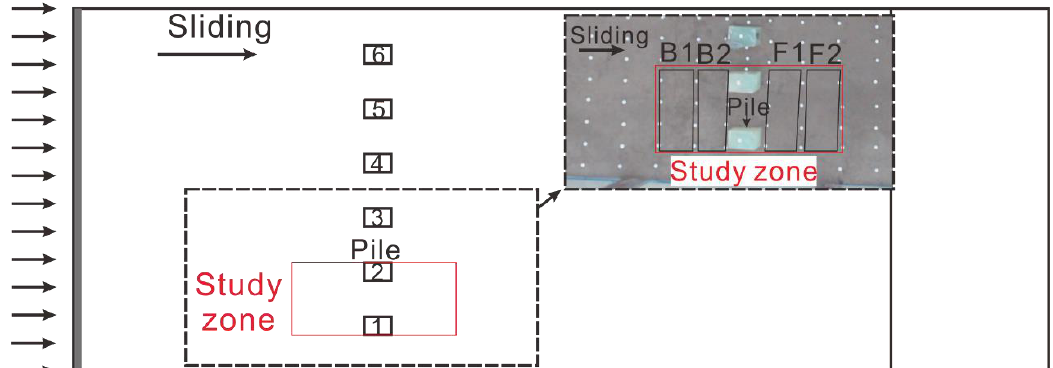
Figure 4. Study zone of the model. The zone is divided into five areas: B1, B2 are located upstream of the pile, F1 and F2 are located downstream of the pile. Pile 2 is selected to study the temperature characteristics of piles.